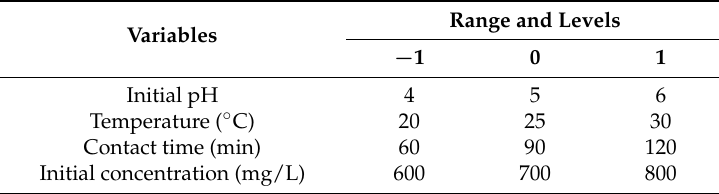
Table 1. Values of independent variables.